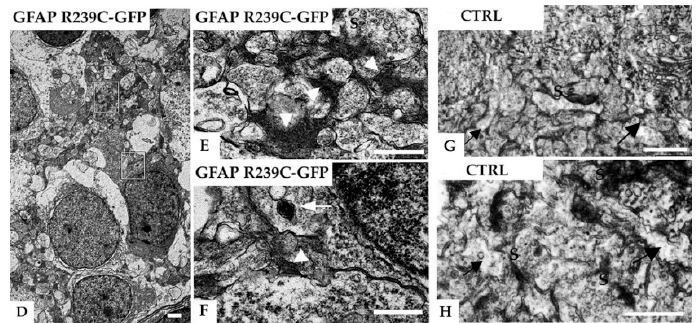
Figure 11. Electron micrographs of radial glial cells in the subventricular and neuropil region in the telencephalon of a 5 dpf zebrafish injected with GFAP-R239C-GFP plasmid. ( A ) A glial cell contacts the ventricular brain surface covered by the tela choroidea (top) and shows many electron-dense profiles. In ( B , C ), higher magnifications of the marked areas in ( A ) reveal that the dark profiles are associated with filaments (arrowheads) and sometimes surrounded by a membrane (arrows), the latter consistent with lysosomal packaging. In another example of the neuropil region shown in ( D ), at higher magnifications of the marked areas depicted in ( E , F ), glial processes containing electron-dense fibrillar material can be seen (arrowheads). The arrow points at a membrane-bound vesicle containing clustered electron-dense material, featuring a lysosome. In ( G – J ), electron microscopic analyses on control wildtype embryos of similar regions are shown, i.e., subventricular glial processes in ( G , H ) and neuropil region in the telencephalon in ( I , J ). No such electron-dense material in glial processes, identified by their irregular shape in the synaptic regions (arrows), was detected in the control tissue. Note that the dark bands are postsynaptic densities (S: presynaptic terminals). Scale bars: ( A , D ) 1 µ m; ( B , C ) 250 nm; ( E – J ) 500 nm.